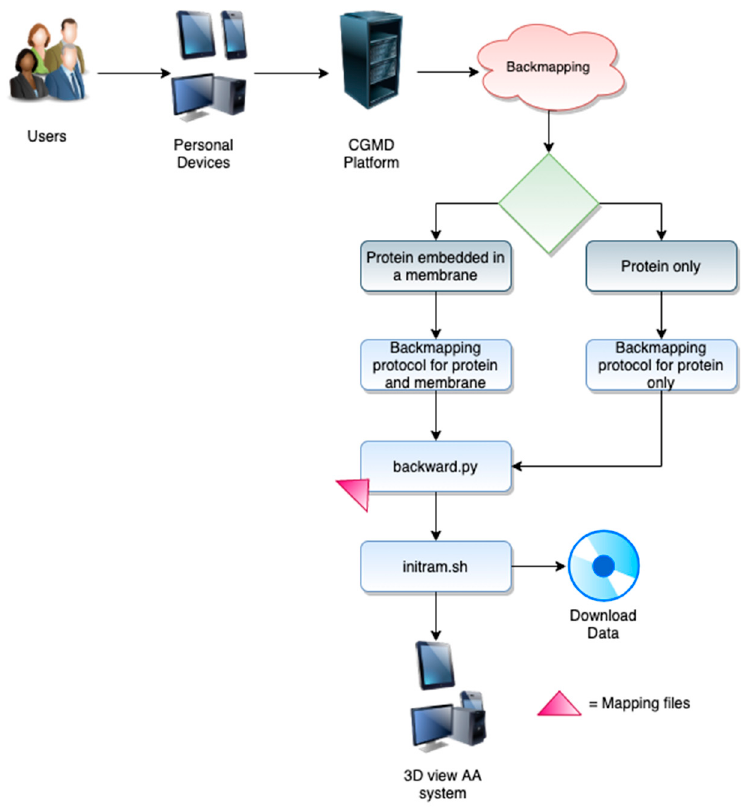
Figure 3. The backmapping workflow.